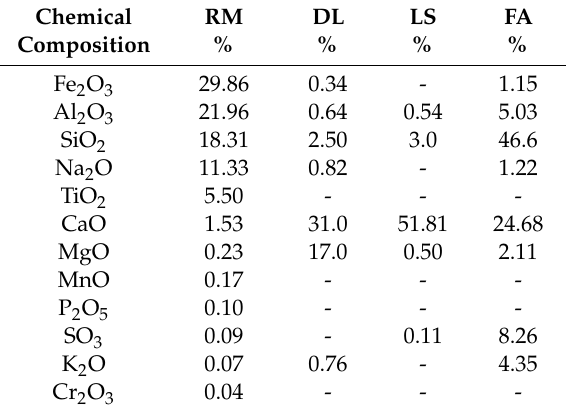
Figure 1. Particle size distribution of different fillers.